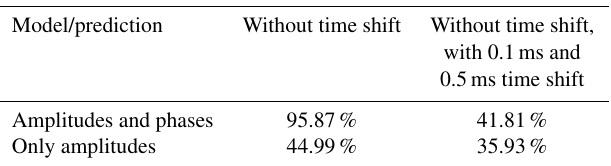
Figure 14. Classification error for one fold of the 10-fold cross val- idation using the 2kHz raw data set for the model training and con- stant time-shifted data sets for the application of the trained model. Red dots represent models based on both amplitude and phase fea- tures, while green dots represent models using amplitude data only. Table 4. Classification error for the prediction of the data set with 1ms time shift by using different